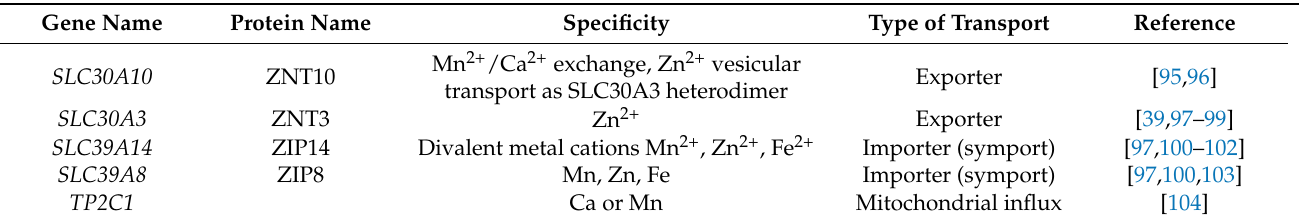
Table 1. Representative Mn 2+ and Zn 2+ ion carrier